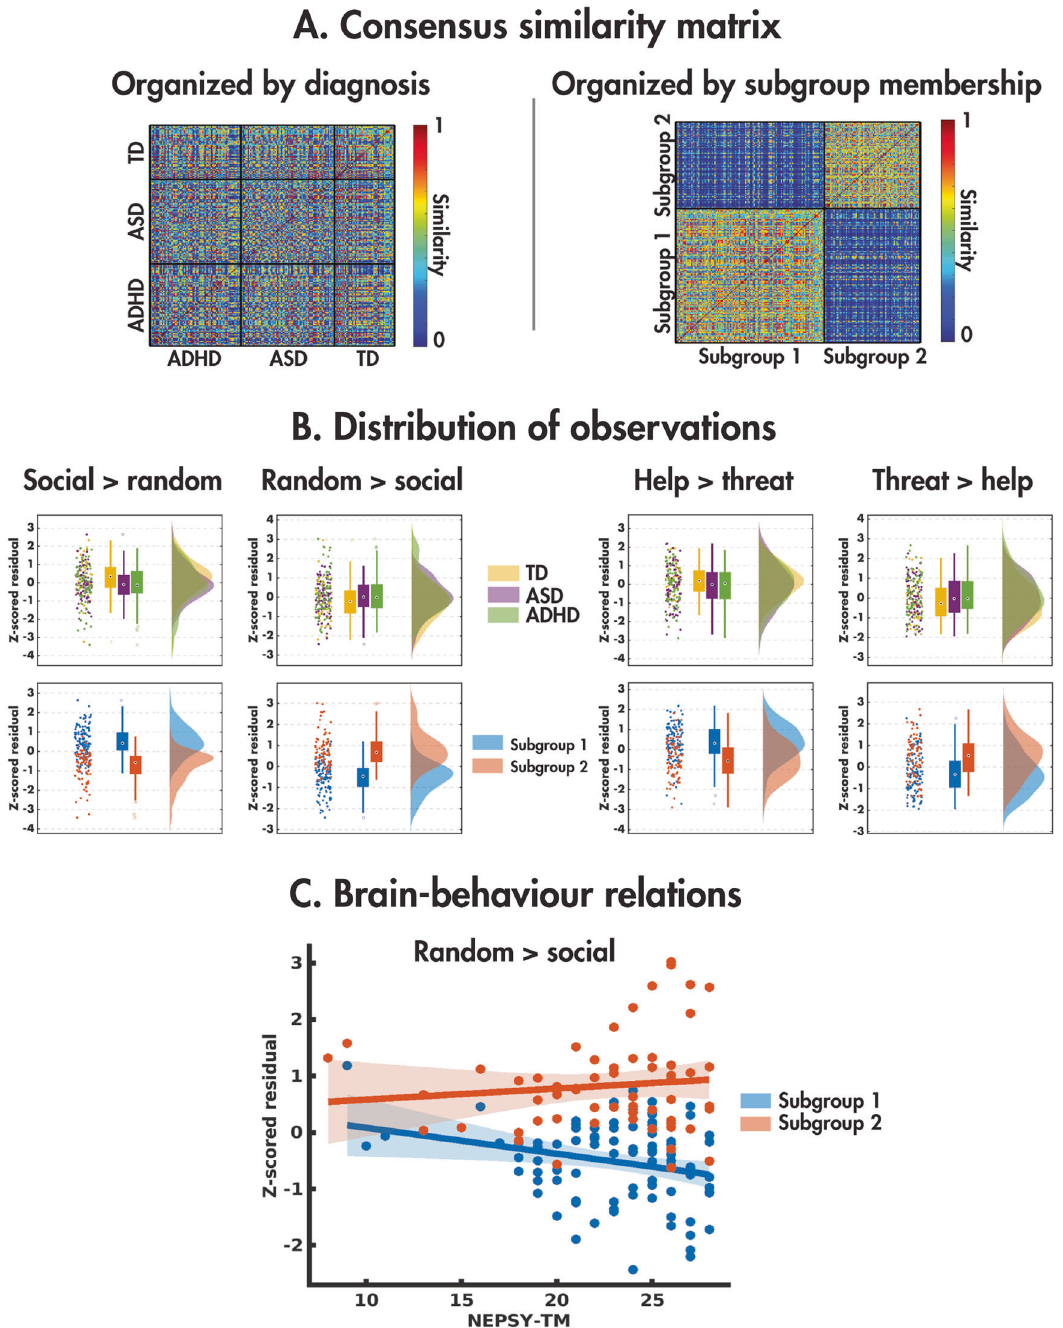
Fig. 5 Results of the data-driven subgrouping analysis. The consensus similarity matrix organised by the diagnostic group is shown ( A ) alongside its reorganisation by cluster membership, with the distributions ( B ) of the four observations used in the clustering in the diagnostic groups (top) and subgroups (bottom). A signi fi cant brain – behaviour interaction was found with the NEPSY-TM ( C